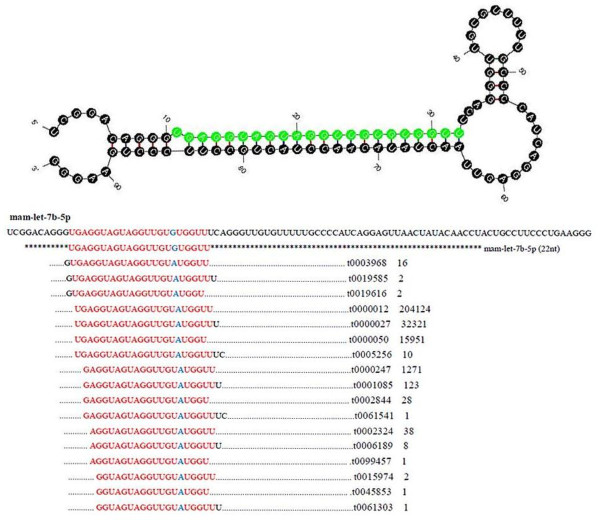
Details of mam-let-7b-5p isomiRs including sequence count. A portion of the miRNA precursor, multiple isomiRs with their sequence counts and the pre-miRNA secondary structure with dominant cleavage sites are presented. The most abundant mature miRNAs are indicated by the sequence in green.